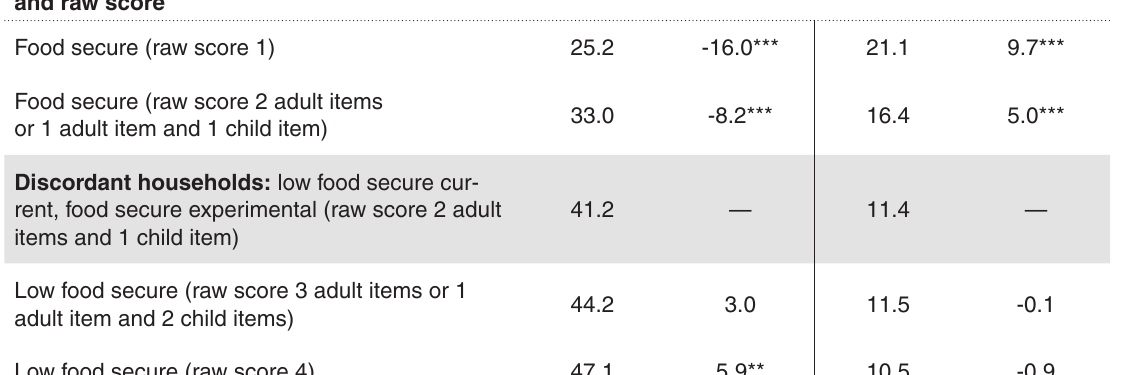
Percent of households with children reporting unmet food needs or could spend less on food, by food security status, 2008-15 1 Panel A: household food security status on current and experimental classification methods and raw score